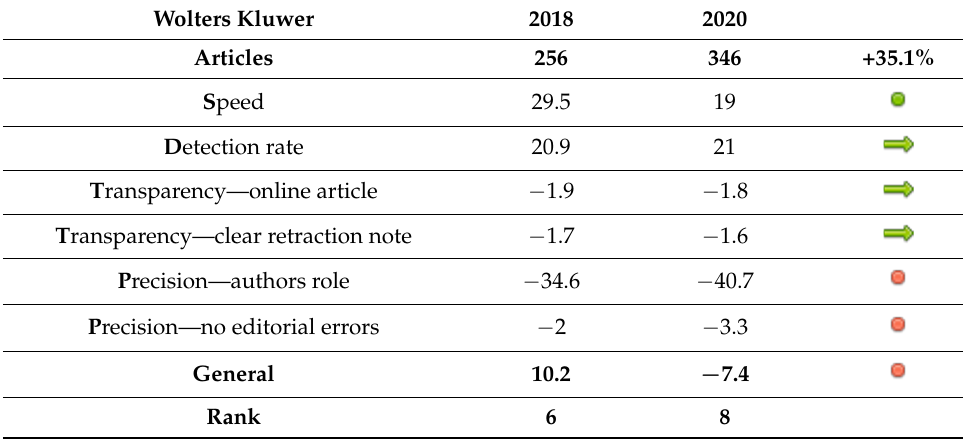
Table 17. Wolters Kluwer 2018 – 2020 change of SDTP score.